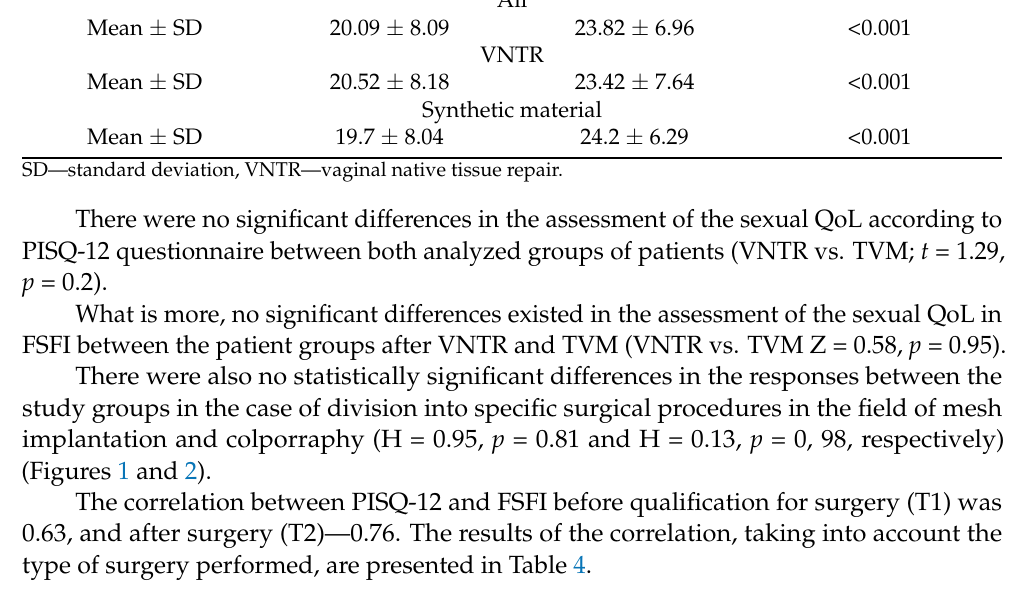
Table 4. Spearman’s rank correlation coefficient (PISQ-12 and FSFI) depending on the type of surgery. The Type of Surgery T1 T2 TVM 0.60 0.75 VNTR 0.66